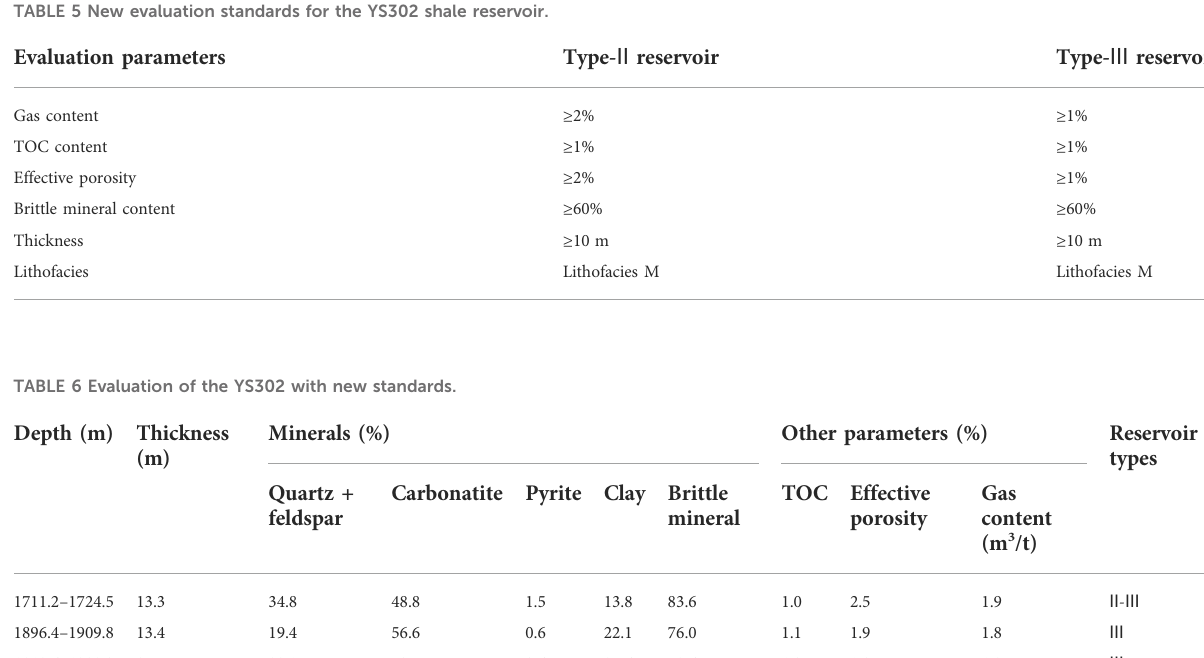
TABLE 5 New evaluation standards for the YS302 shale reservoir.